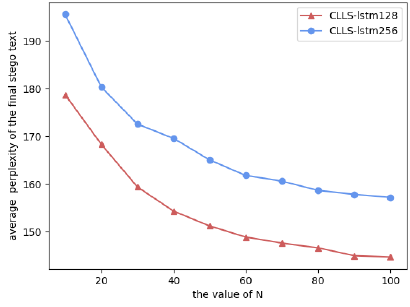
Figure 6. The average perplexity values for different N